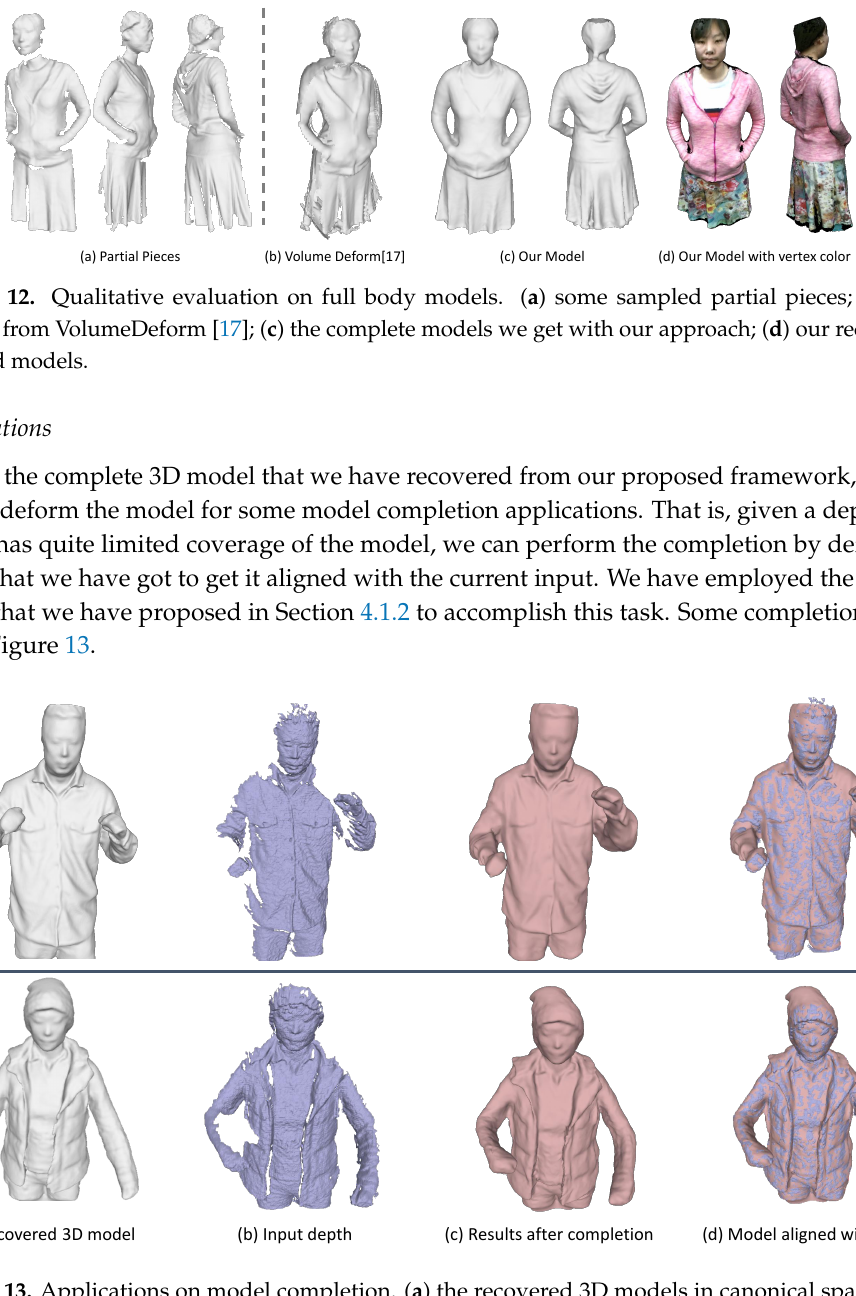
Figure 13. Applications on model completion. ( a ) the recovered 3D models in canonical space from our proposed framework; ( b ) some input depth frames which capture only partial of the model; ( c ) the results after model completion; ( d ) the aligned meshes of our model after completion and the input